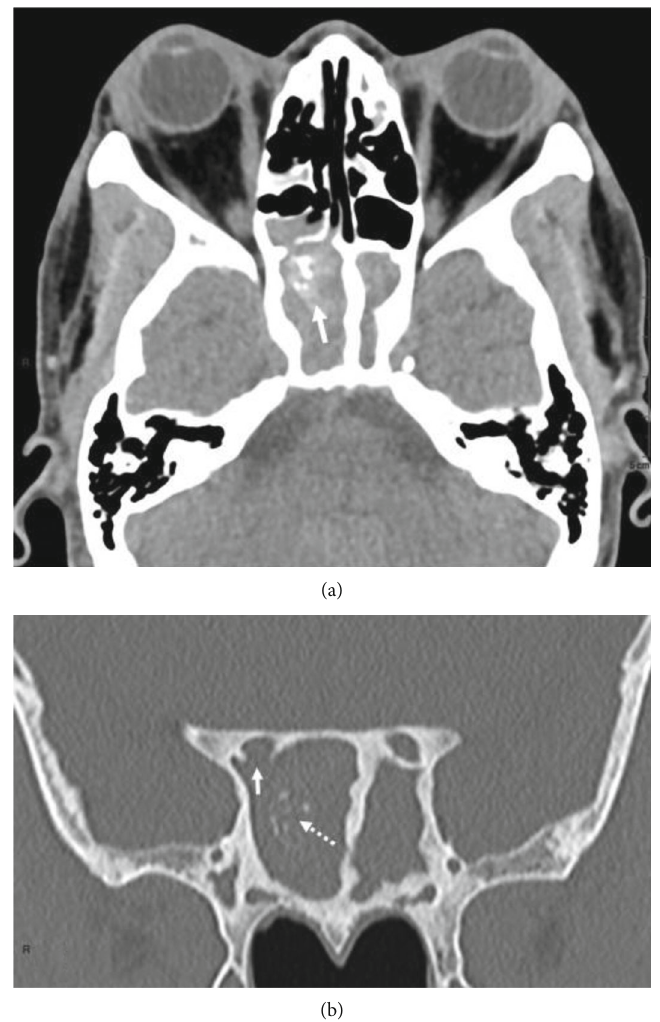
Figure 1: Head computed tomography scan. (a) Unenhanced axial transverse view in parenchymal reconstruction algorithm showing fi lling of the sphenoid sinus and of the right-sided posterior ethmoid cell by in fl ammatory material. Observe heterogeneous and amorphous calcium deposits within the right sphenoid cell (arrow). (b) Coronal reformatted view through the sphenoid in bone reconstruction algorithm showing disruption of the fl oor of the right optic canal (arrow). Observe calcium deposits within the sphenoid sinus (dotted arrow) and bone thickening of the sphenoid